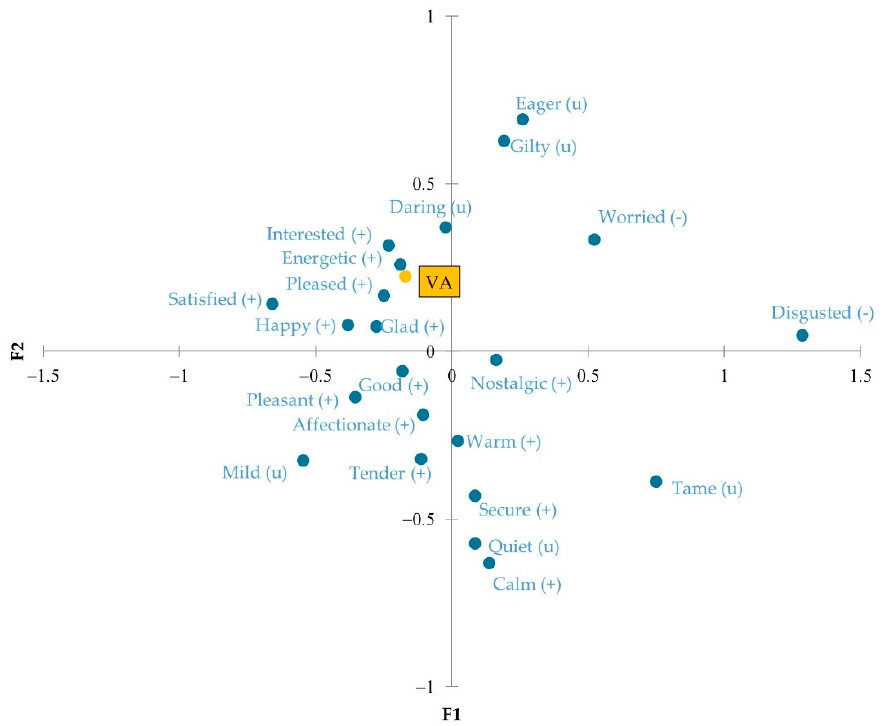
Figure 4. Principal coordinates analysis with the variable “visual acceptance” (VA) of the significant emotional responses obtained with CATA EsSense Profile ® : (+), positive emotion; ( − ), negative emotion; (u), neutral emotion.